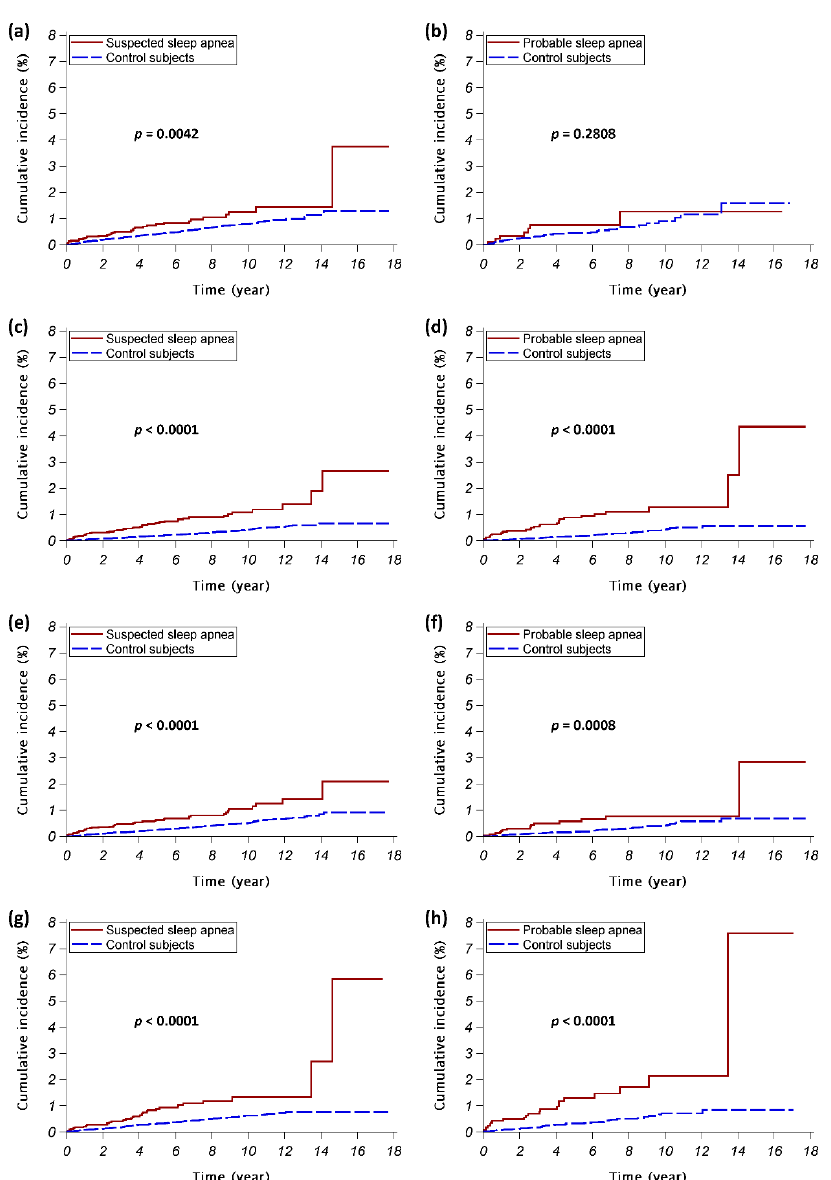
Figure A1. The cumulative incidences of temporomandibular disorder in female subjects ( a,b ), male subjects ( c,d ), subjects ≤ 50 years of age ( e,f ), and subjects > 50 years of age ( g,h ). The analyses were taken in study arm A (suspected SA vs. control A) (a,c,e,g) and study arm B (probable SA vs. control B) (b,d,f,h). The red continuous lines and blue dashed lines show the cumulative incidence of temporomandibular disorder for the sleep apnea (SA) patients and the control subjects, respectively.